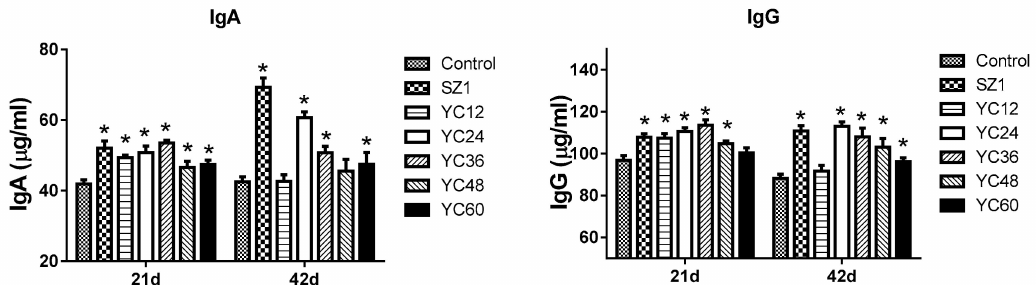
Figure 1. E ff ects of dietary yeast culture (YC) supplement on the concentrations of immunoglobulins in broiler serum at 21 and 42 days. IgA = immunoglobulin A, IgG = immunoglobulin G. The asterisk (*) denotes significant di ff erences ( p < 0.05) compared with the control group using one-way analysis of variance (ANOVA). Values are means ± standard